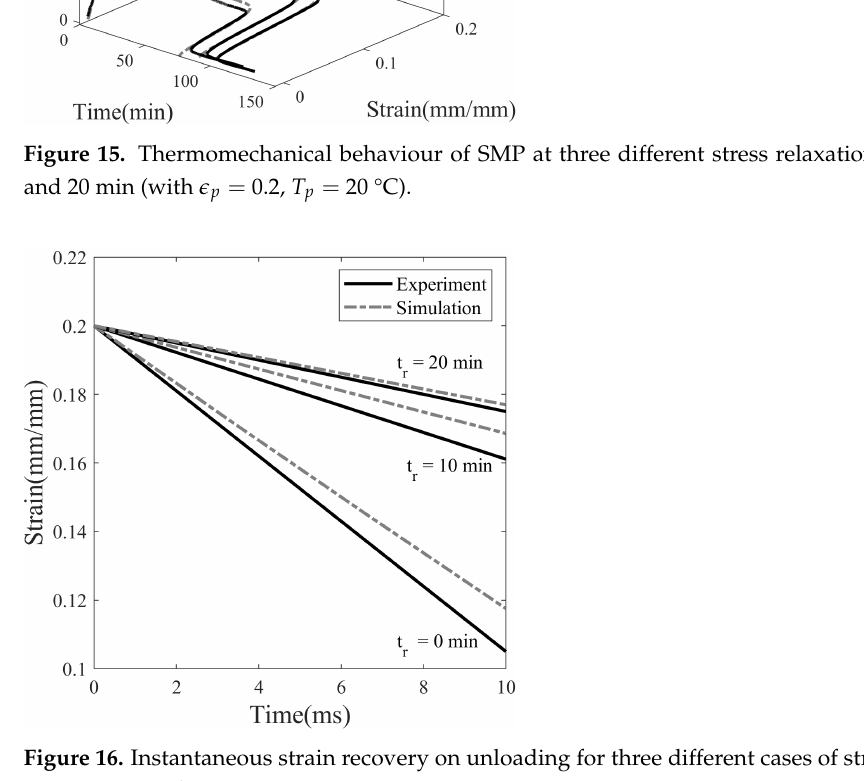
Figure 16. Instantaneous strain recovery on unloading for three different cases of stress relaxation times: 0, 10, and 20